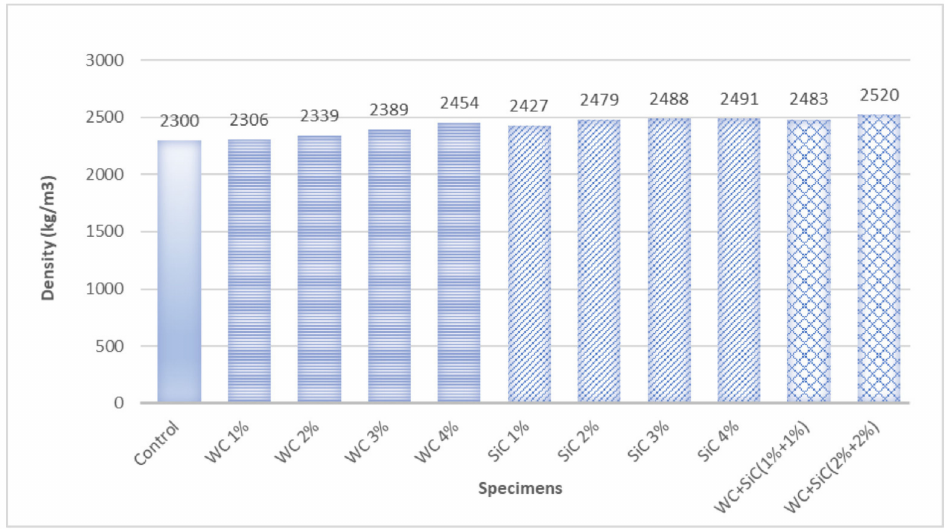
Figure 4. Density of all